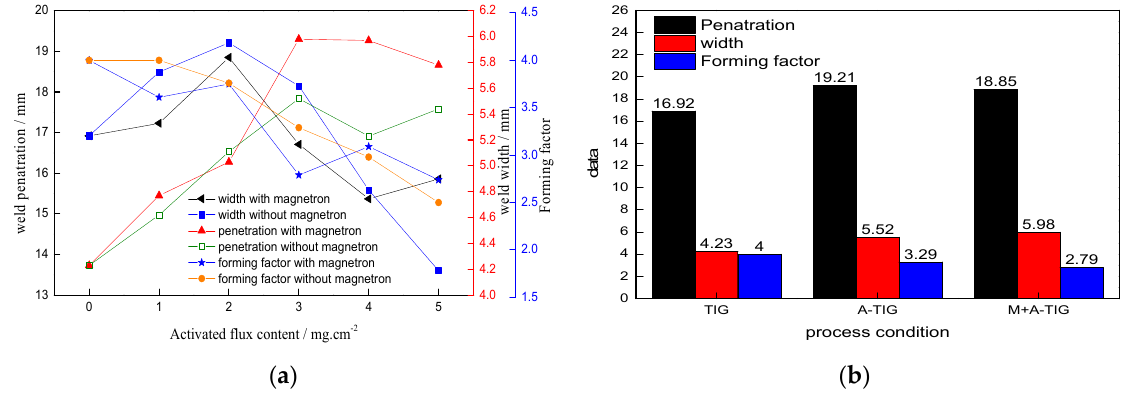
Figure 3. Formation of the joints with and without magnetic field. ( a ) Under different flux coating amounts; ( b ) Under different process.